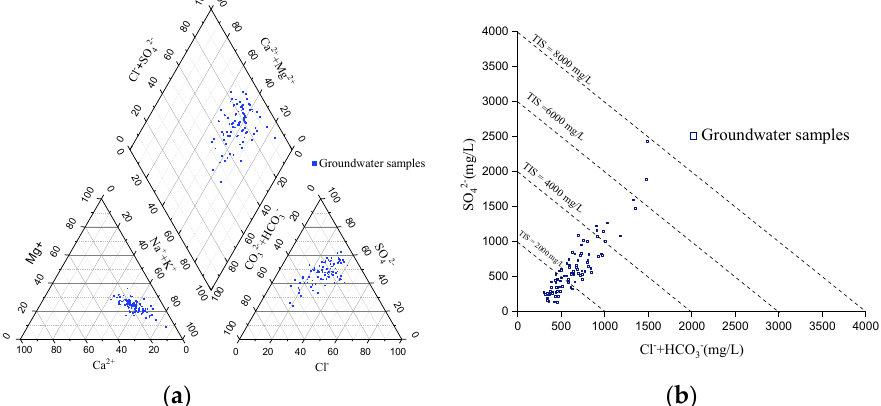
Figure 7. All 90 wells of groundwater samples shown in ( a ) Piper diagram and ( b ) Total Ionic Salinity (TIS) diagram.